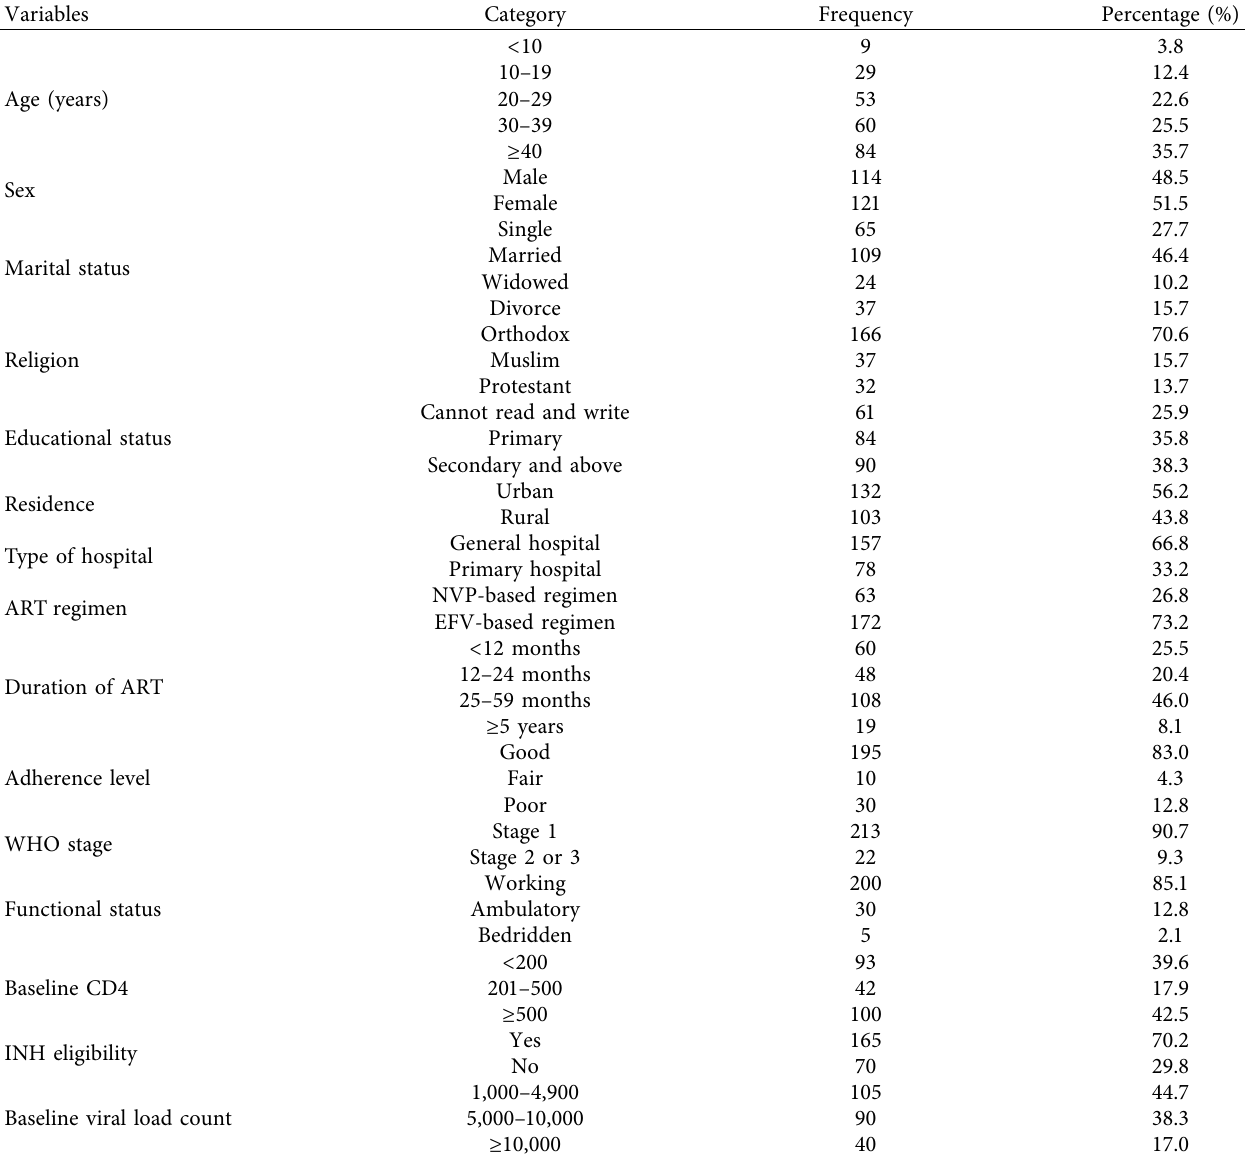
Table 1: Sociodemographic and clinical characteristics of high viral load HIV seropositive people from June 2016 and January 2019, North Wollo Zone,